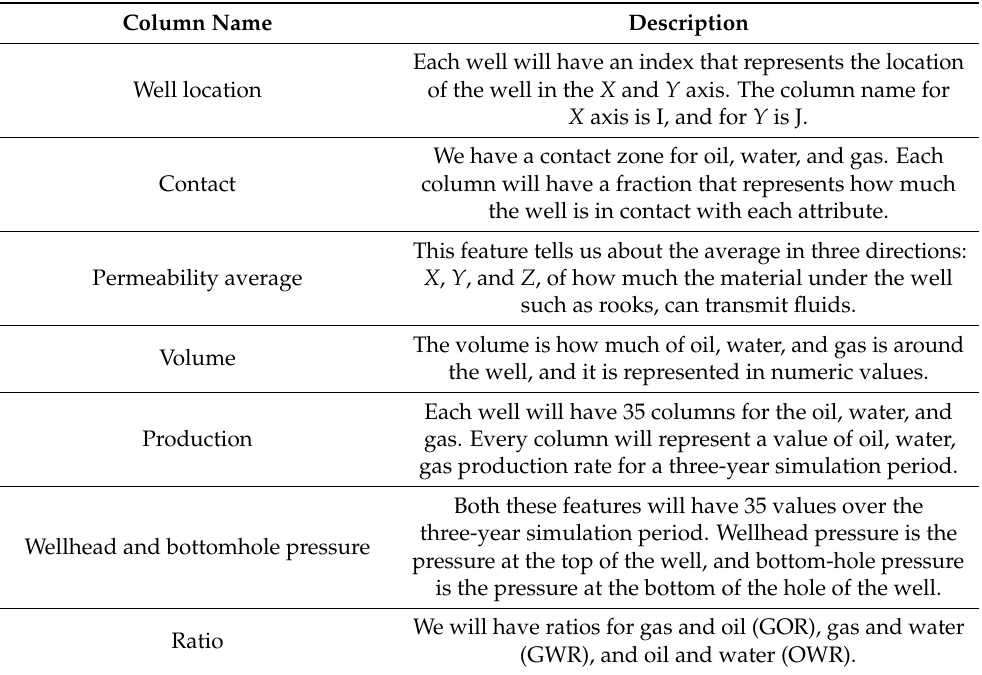
Table 1. Dataset